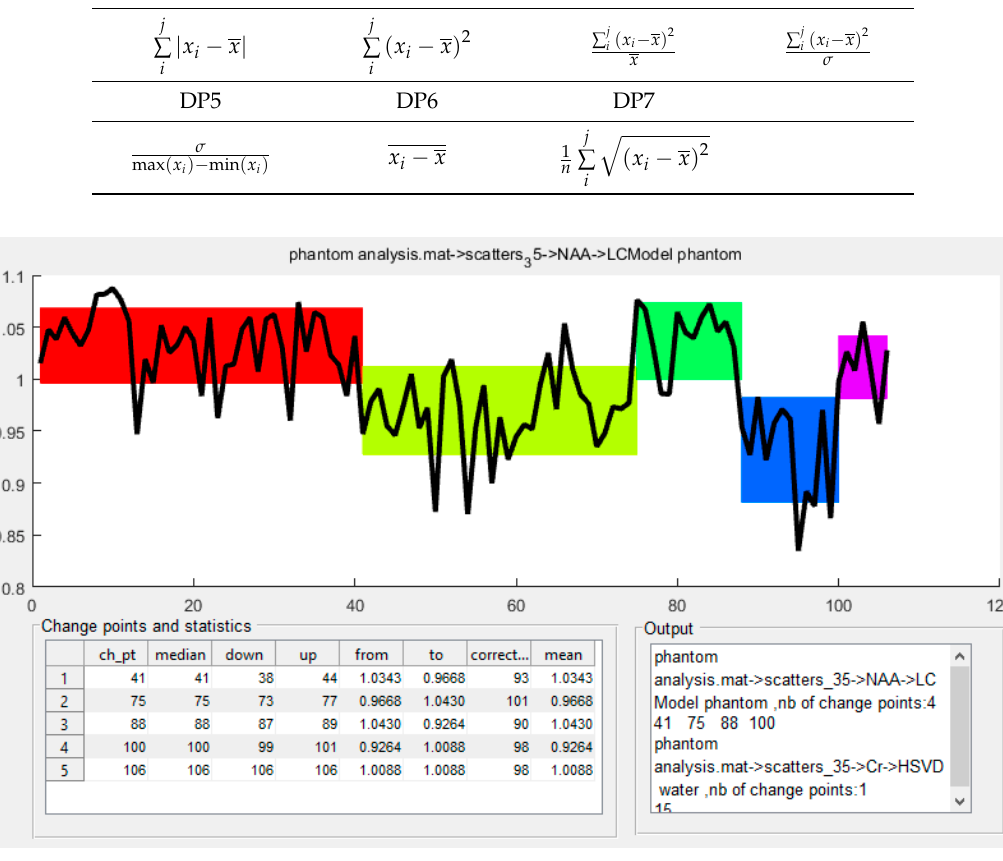
Figure 1. The main window of the time series analysis tool for quality control showing the change points and the statistics results obtained for exemplary data. The color bands correspond to the mean values (± standard deviation) of the signal in the monitored time intervals. The table in the lower-left corner presents: change points (ch_pt), medians, lower and upper confidence intervals (down and up), magnitude of the signal change (from/to) expressed as the mean signals in the time intervals before and after the change point, the correction factor computed as: (mean signal in the time interval after the change point/mean signal in the first interval) × 100%, mean signal in the time period before the change point.